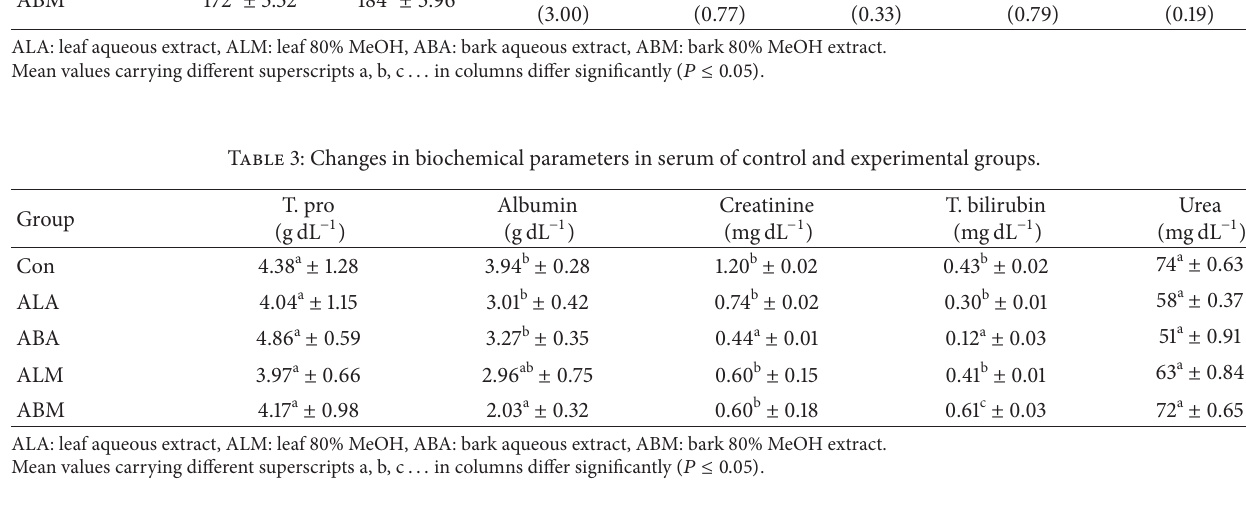
Table 4: Total protein and albumin contents in liver, kidney, and brain (gdL −1 ).